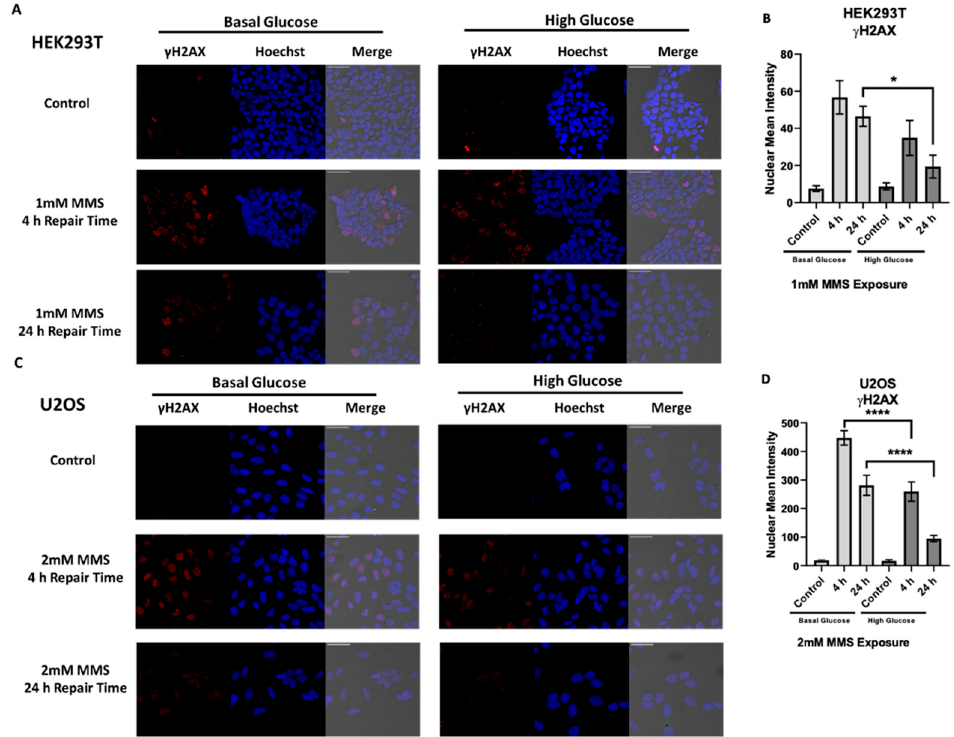
Figure 4. Acute glucose exposure reduced γ -H2AX signaling after MMS exposure, indicating de- creased DNA damage signaling and resolution of DNA strand breaks. ( A ) Representative immunofluorescence images of basal glucose (BG) HEK293T and acute high glucose (HG) HEK93T 4 and 24 h post 1 mM MMS. ( B ) Nuclear mean fluorescent intensity of γ -H2AX in BG and HG HEK293T. ( C ) Representative immunofluorescence images of BG and acute HG U2OS 4 and 24 h post 2 mM MMS. ( D ) Nuclear mean fluorescent intensity of γ -H2AX in BG and HG U2OS. * p < 0.05, **** p < 0.0001. Scale bar is 100 µ